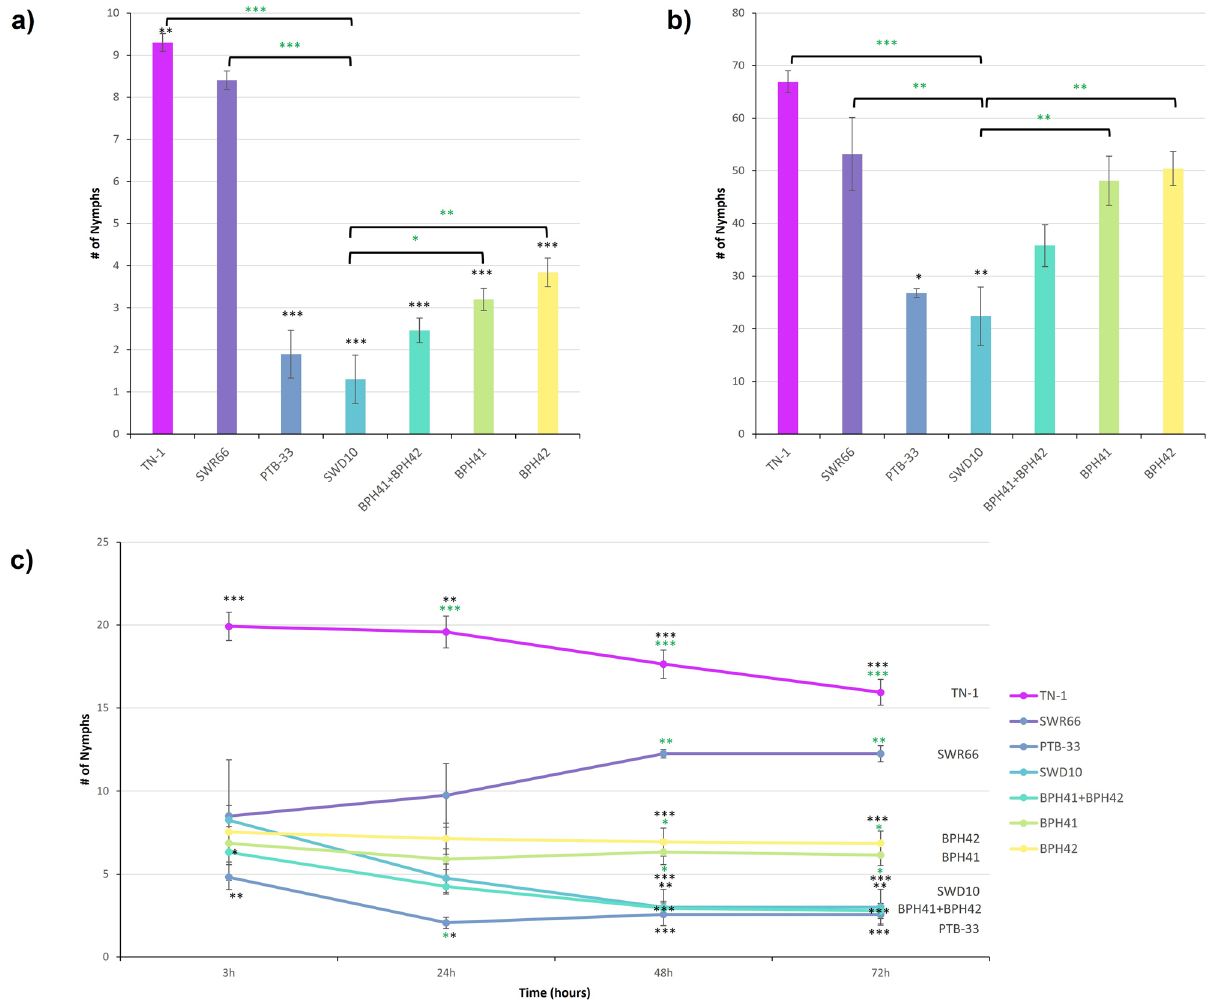
Figure 4. Antibiosis and antixenosis resistance mechanism test results. All genotypes are lines containing the respective resistant allele of the indicated QTLs in the SWR66 background except parental and control lines. ( a ) Results for nymph survival antibiosis test. The number on the y-axis indicates the mean number of nymphs that survived in the antibiosis nymph survival test 20 days post BPH infestation (mean ± s.e; n = 10). ( b ) Results for population growth antibiosis. The number on the y-axis indicates the mean number of F 1 nymphs that emerged after 35 days post BPH infestation (mean ± s.e; n = 5). ( c ) Results for antixenosis test. The number on the y-axis indicates the mean number of nymphs that remain on each genotype, counted at 3 h, 24 h, 48 h and 72 h post BPH infestation (mean ± s.e; n = 4). Black “*” indicate genotypes that are significantly different compared to SWR66. Green “*” indicate genotypes that are significantly different compared to SWD10. *p value < 0.05, **p value < 0.01, ***p value <